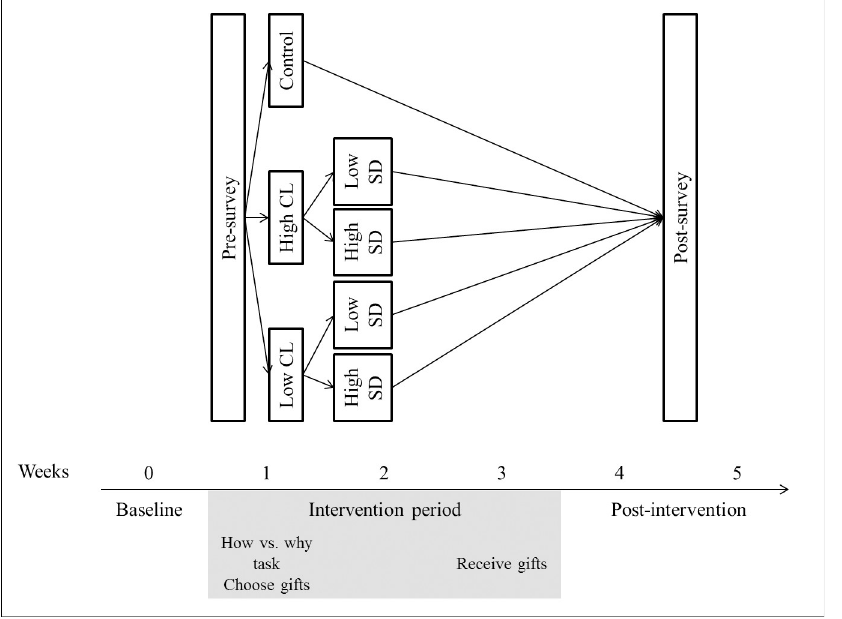
Fig 1. Design of experiment. CL = construal level, SD = social distance.